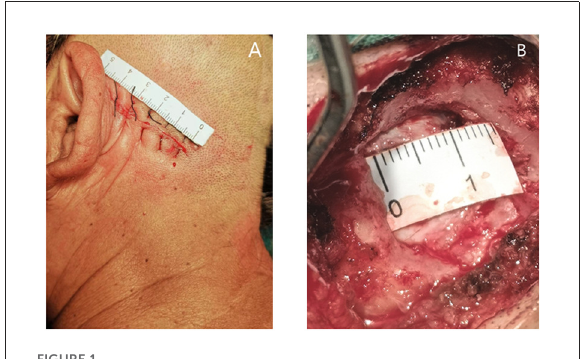
FIGURE1 (A) Location and length of surgical incision; (B) Size of bone